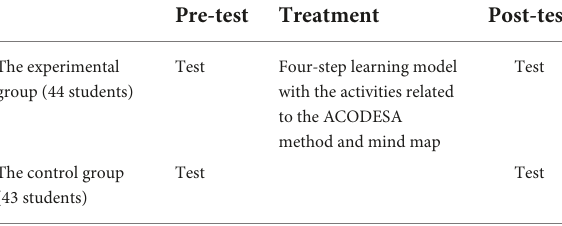
TABLE 1 The quasi-experiment study